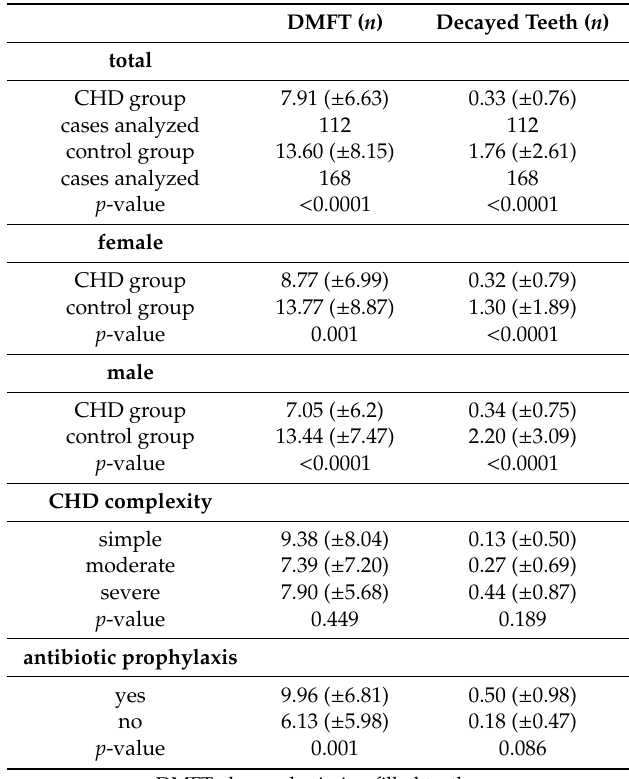
Table 2. With caries among patients with CHD and healthy control subjects. Analysis of di ff erences between groups has been done with Mann–Whitney test, analysis between subgroups (CHD complexity) with Kruskal–Wallis test.